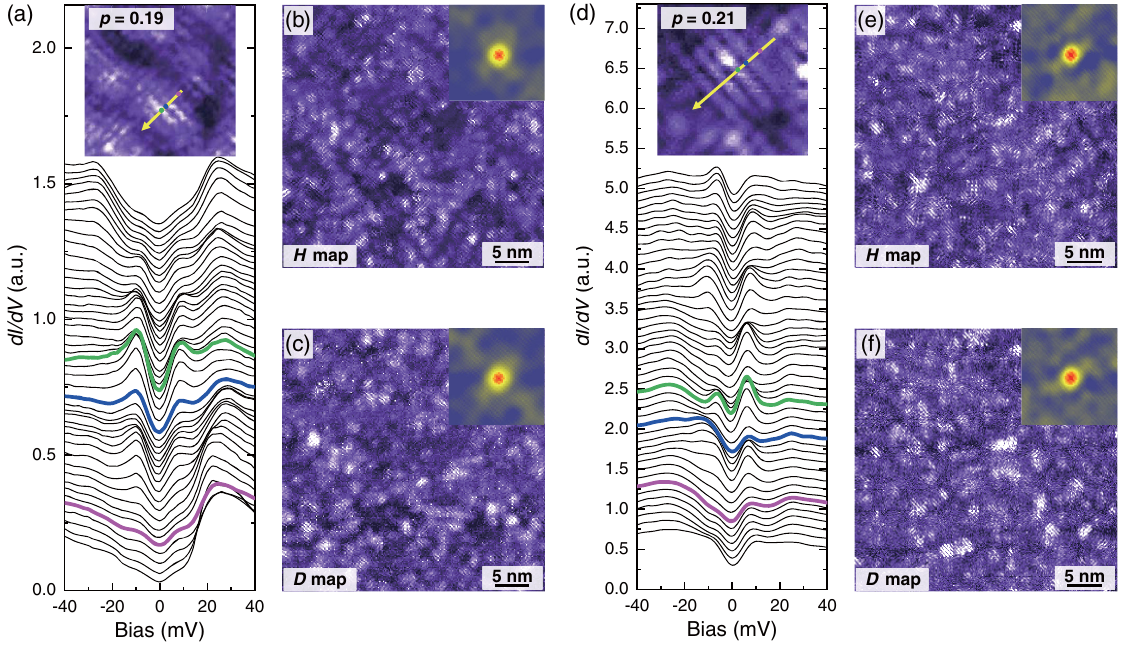
FIG. 7. The pair density modulation features in two overdoped SC samples. (a),(d) Spectral linecuts along the yellow arrows on the OD-24K and OD-15K samples, respectively. The insets are the corresponding dI=dV maps ( 50 × 50 Å 2 ) taken at bias voltage V ¼ 10 mV. (b),(e) The H maps of the OD-24K and OD-15K samples, and the insets are the same cross-correlation plots as in Fig. 6(f). (c),(f) The D maps of the OD-24K and OD-15K samples, and the corresponding cross-correlations are shown in the insets. The maximum at the center indicates a positive correlation between the charge and pair density